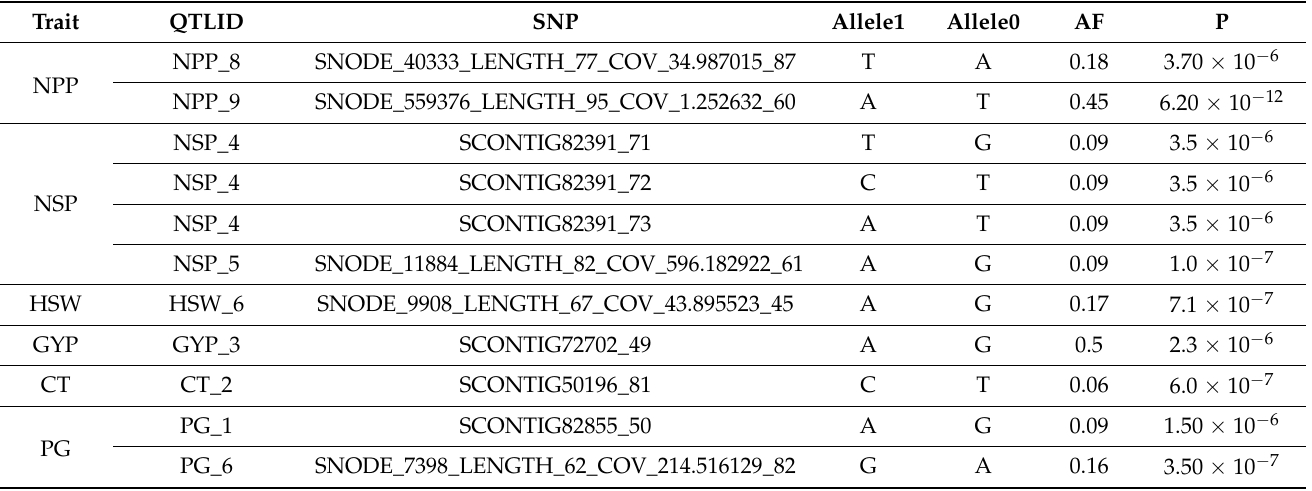
Table 6. SNPs detected in multi-trait genome-wide association study (MT-GWAS) with significant p -values. AF: allele frequency of allele1.